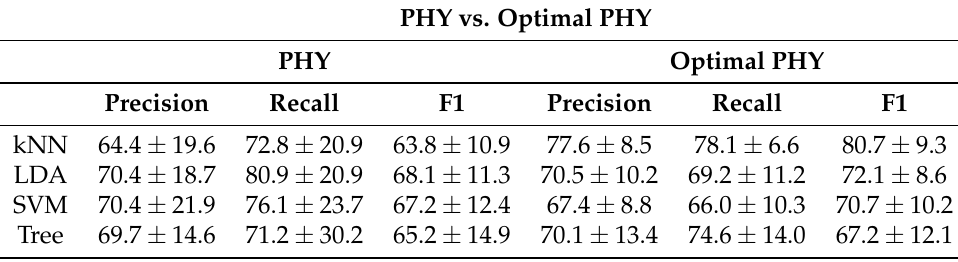
Table A3. Precision, Recall and F1 scores of the PHY vs. Optimal PHY classification